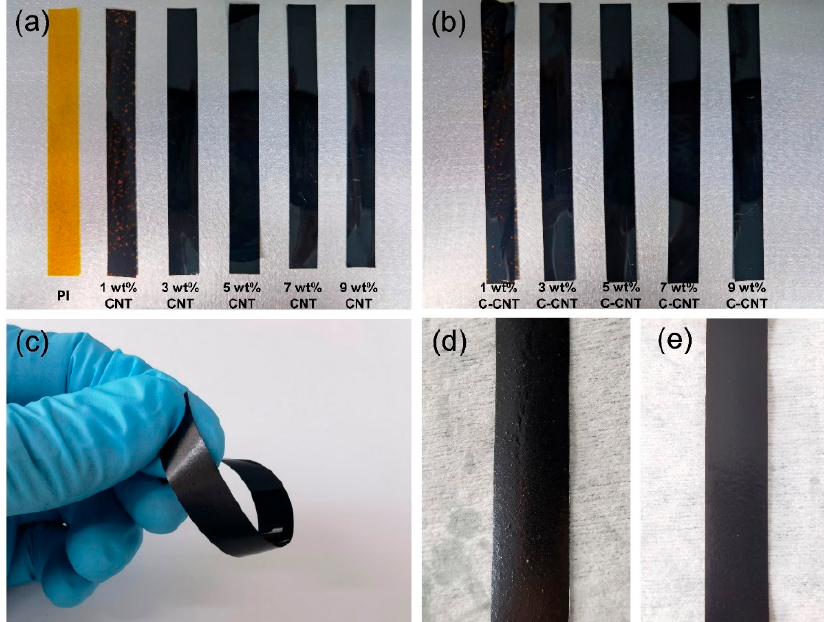
Figure 7. Photographs of PI films with different contents of ( a ) CNT and ( b ) C-CNT, ( c ) the flexible film, ( d ) 9 wt.% CNT/PI film, and ( e ) 9 wt.% C-CNT/PI film.